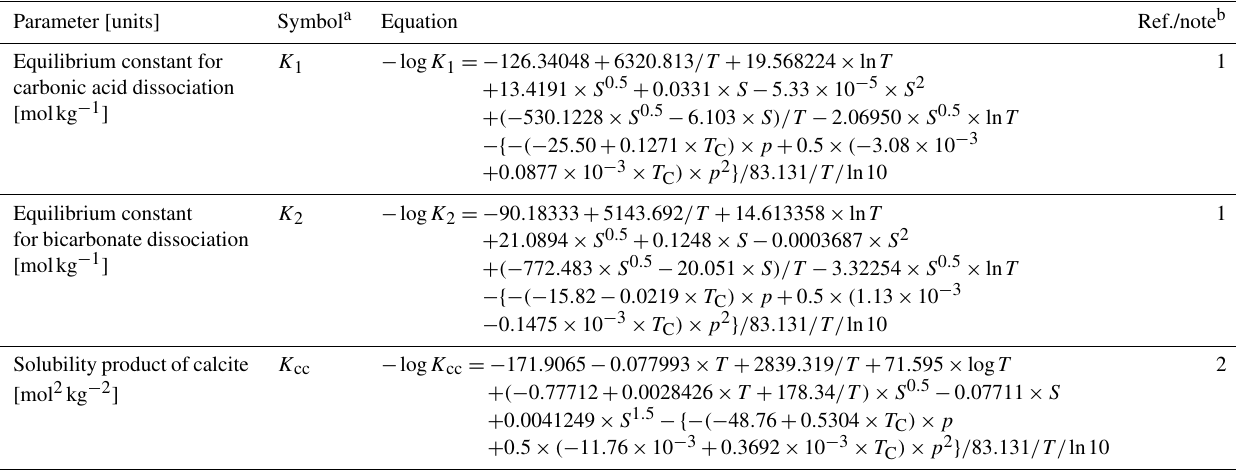
Table 3. Thermodynamic parameters. Parameter [units] Symbol a Ref./note b Equilibrium constant